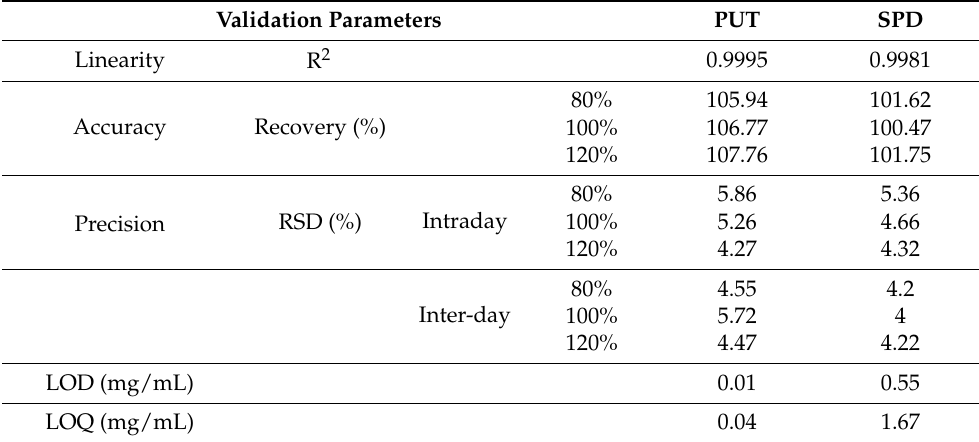
Table 3. Summary results related to the post-column derivatization HPLC method validation of the biogenic amines in the H. erinaceus extract.